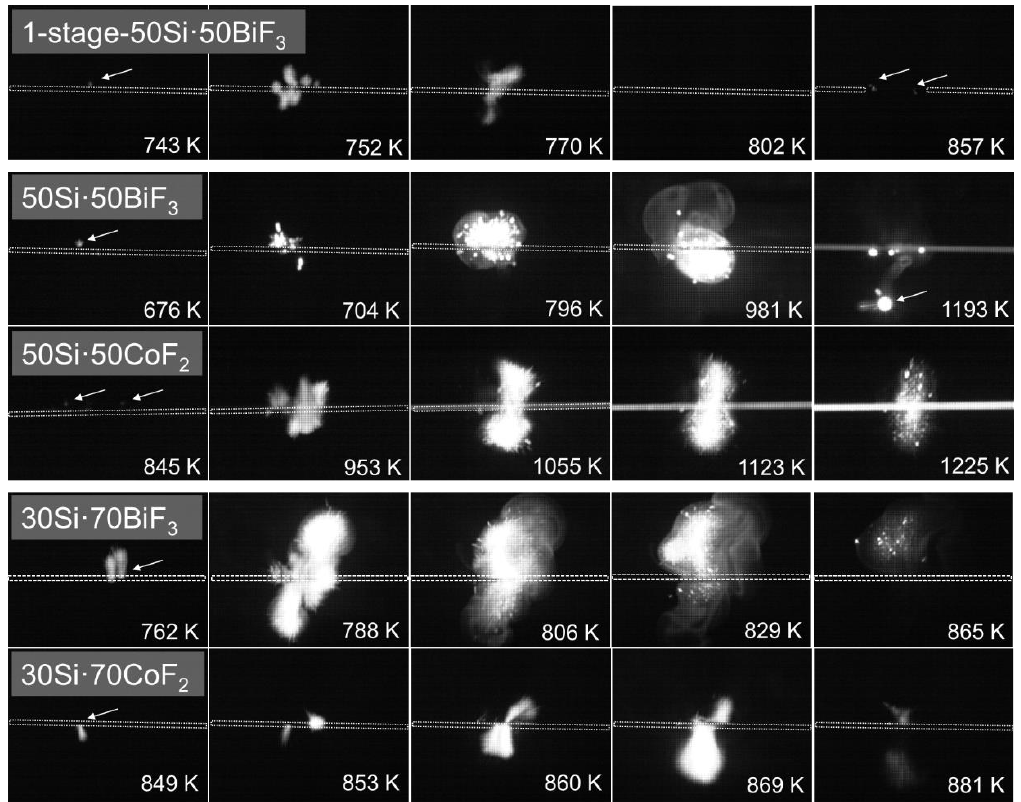
Figure 10. High-speed video frames of the ignition of 1-stage 50Si · 50BiF 3 (heated at 2100 K / s) and two-stage milled materials; 50Si · 50BiF 3 (heated at 3800 K / s), 50Si · 50CoF 2 (heated at 2100 K / s), 30Si · 70BiF 3 (heated at 2200 K / s) and 30Si · 70CoF 2 (heated at 2200 K / s), on an electrically heated nichrome wire. The wire temperatures are indicated.